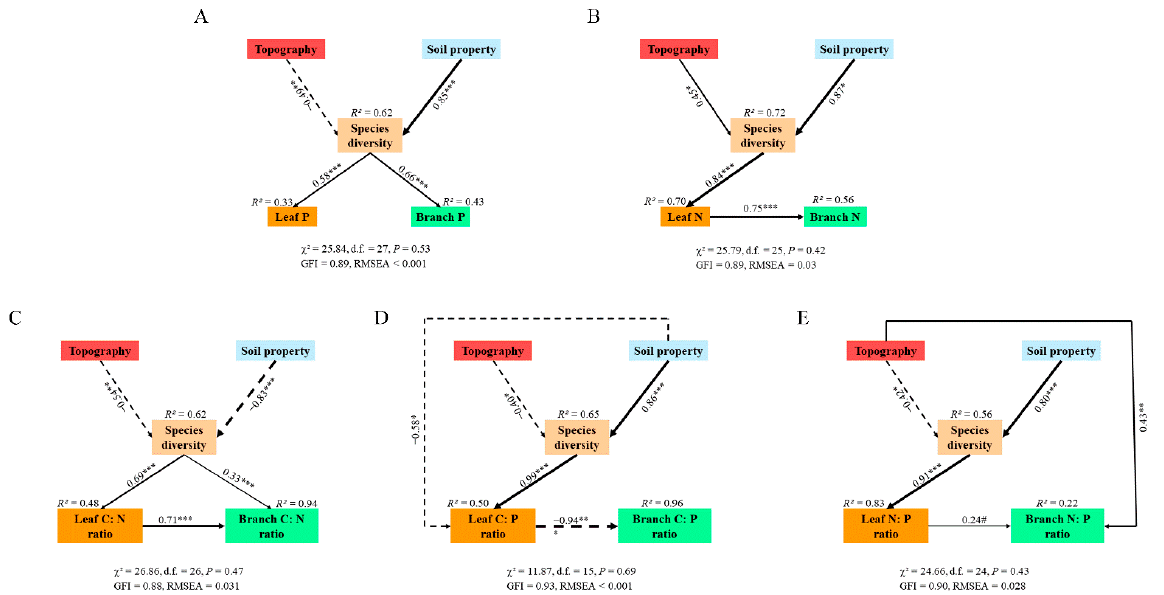
Figure 6. The strength of direct and indirect effects (standardized path coefficients) of topography, soil property, and species diversity on ( A ) leaf and branch P, ( B ) leaf and branch N, ( C ) leaf and branch C:N ratio, ( D ) leaf and branch C:P ratio, and ( E ) leaf and branch N:P ratio. Solid arrows indicate a positive relationship, and dotted arrows indicate a negative relationship. The numbers adjacent to the arrows are the standardized path coefficients and the arrow width indicates the strength of the standardized path coefficient. R 2 values represent the proportion of the variance explained for each endogenous variable. χ 2 , chi-squared values; d.f., degree of freedom; GFI, goodness-of-fit index; RMSEA, the root mean square error of approximation. # p < 0.10, * p < 0.05, ** p < 0.01, *** p < 0.001.